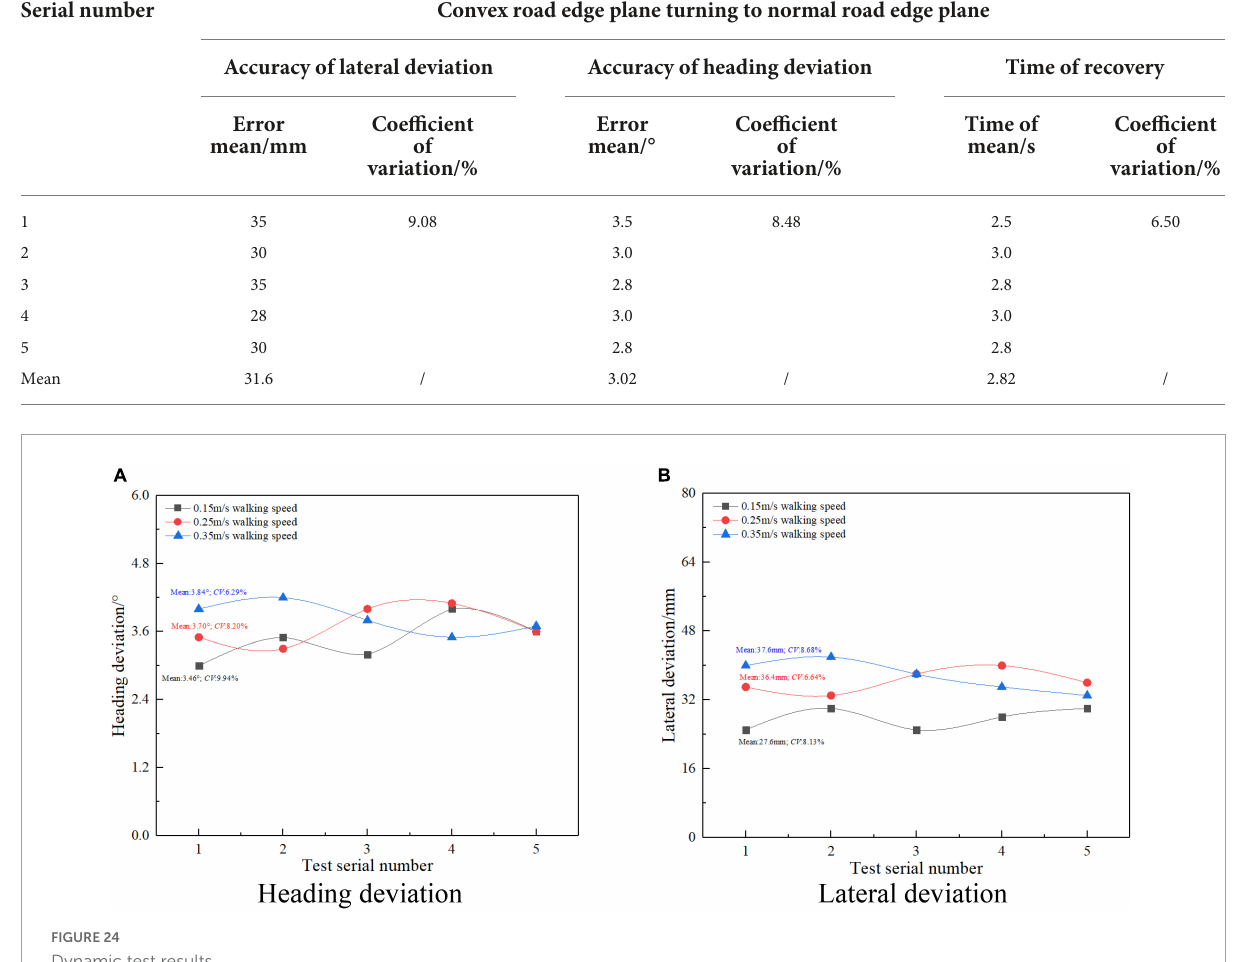
TABLE 9 Test results of detection performance of a convex road edge plane turning to a normal road edge plane.